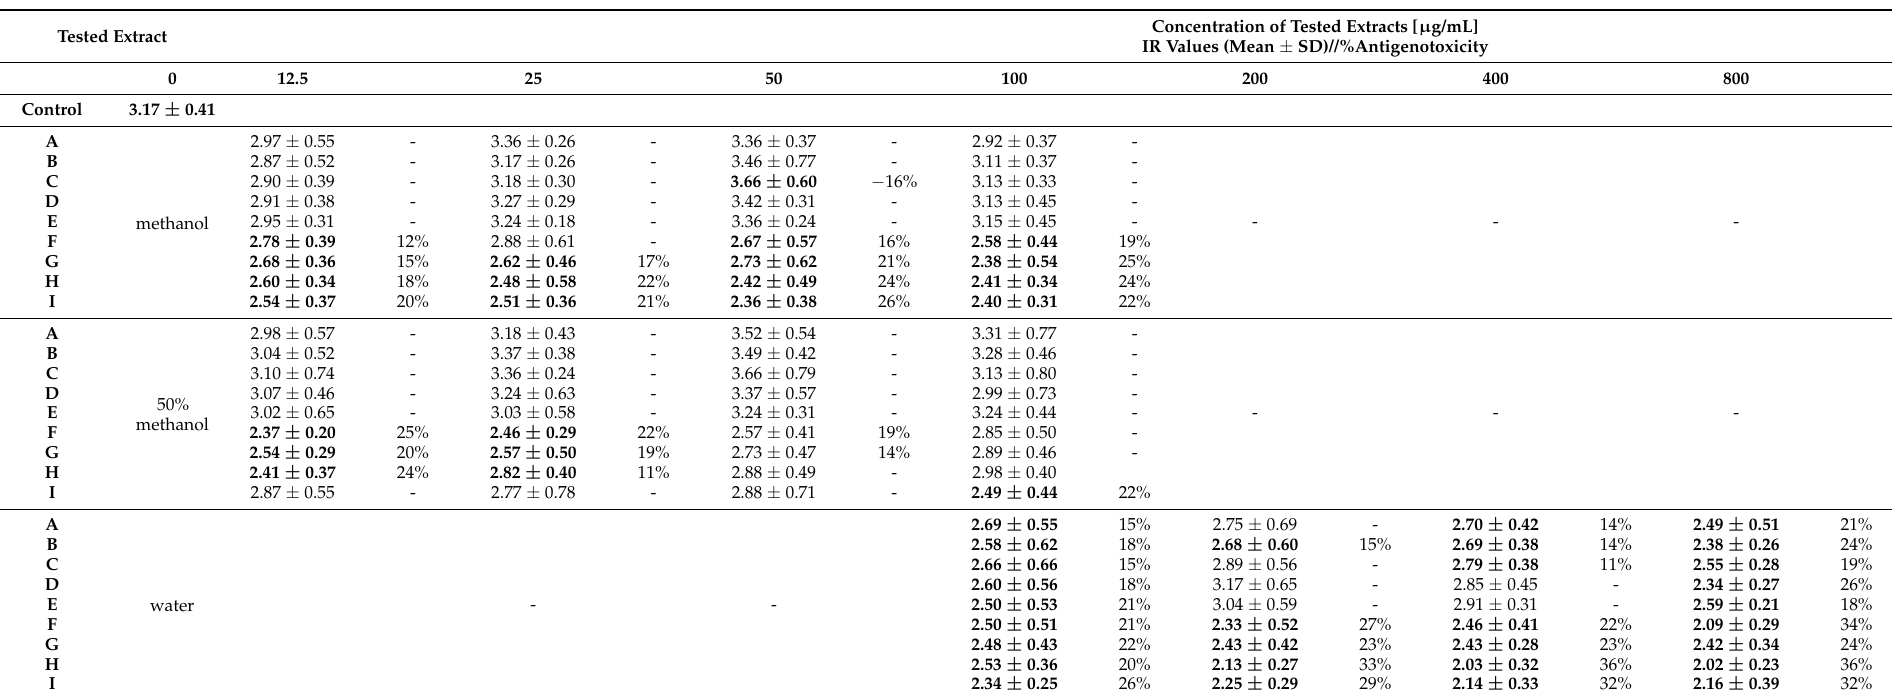
Table 4. Evaluation of anti-photogenotoxic activity based on IR values for the control—photogenotoxin chlorpromazine (CPZ 5 µ g/mL)—and the mixture of CPZ with extracts dissolved in methanol, 50% methanol, or deionized